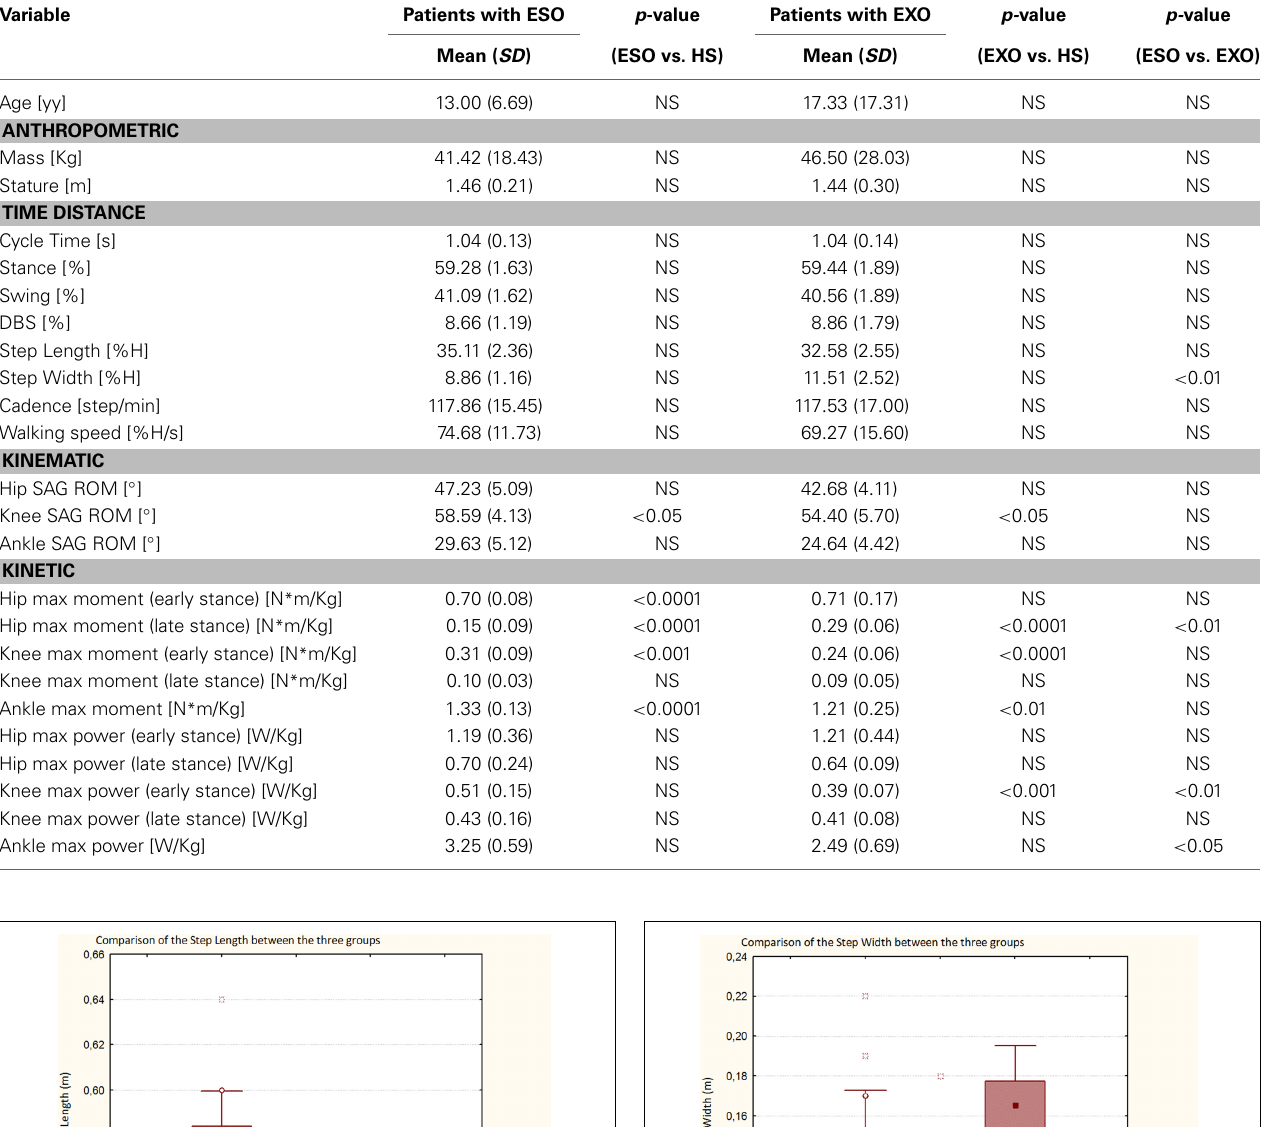
Table 3 | Comparison between groups: patients with esotropic strabismus (ESO) vs. Healthy Subjects (HS); patients with exotropic strabismus (EXO) vs. Healthy Subjects (HS).